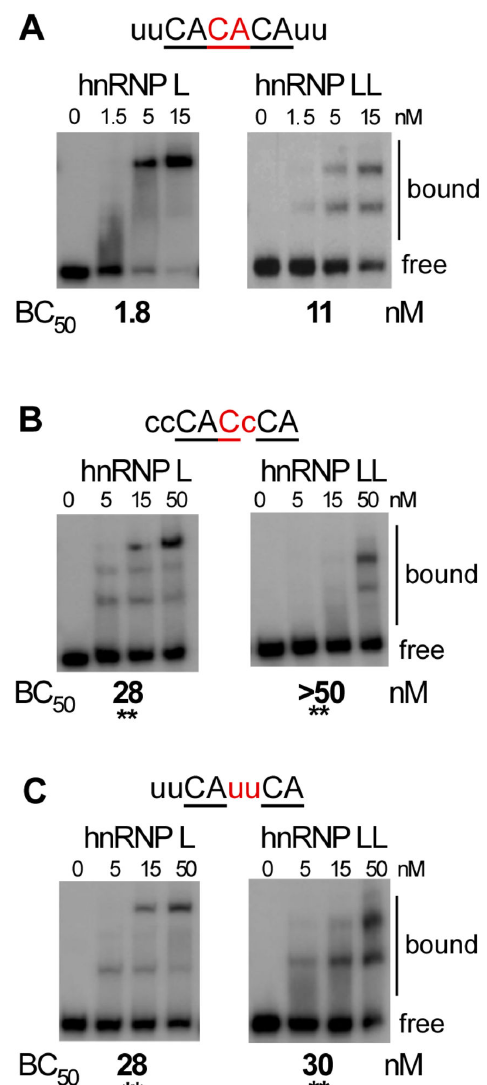
Figure 5. A pyrimidine residue prior to the second CA is detrimental to the binding of both hnRNP L and hnRNP LL. (A-C) Representative native gel analysis (EMSA) of purified, recombinant GST-tagged hnRNP L or Flag-tagged hnRNP LL incubated with radiolabeled T7-transcribed RNAs corresponding to a variant of the sequence in panel 3A. For each panel the sequence shown was substituted at the capitalized positions in panel 3A. CA dinucleotides are underlined, spacers nucleotides between CAs are in red (all have a 2-nucleotide spacer). Affinities (Concentration of 50% binding = BC ) from at least three independent replicates of 50 the EMSAs are shown below gels. Note panel 5A is the same construct as shown in 3B, duplicated to simplify comparison of binding. Bound and free probe is indicated to the right of each gel. Asterisks indicate BC s which are significantly different 50 from CACACA (** p<0.01), as calculated by a unpaired t-test between binding values determined from a minimum of three independent protein